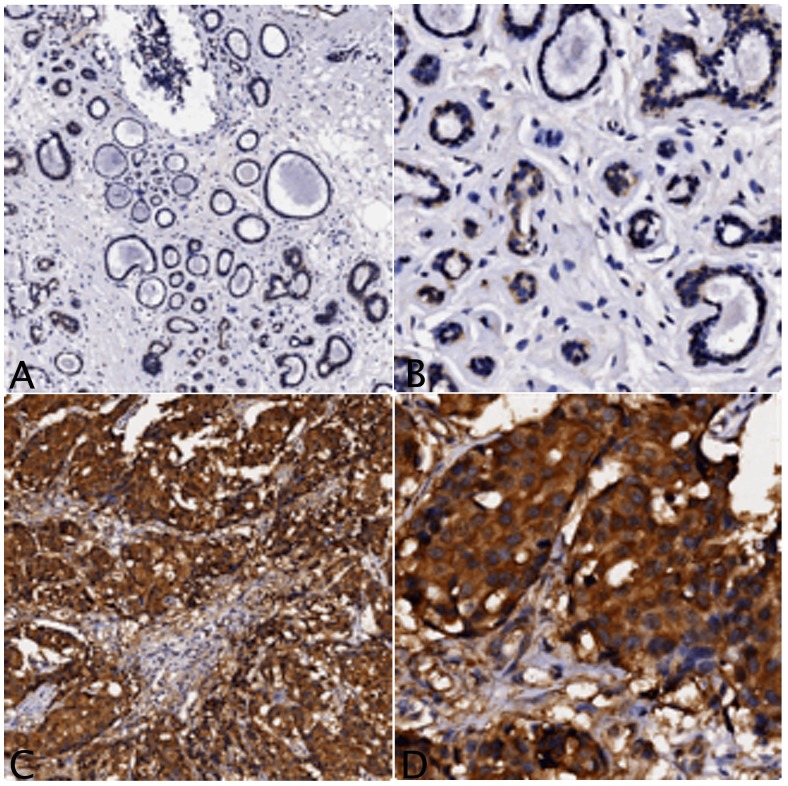
Representative results of XRCC3 protein expression by immunohistochemical analysis.Percentage of positive cells and staining intensity are much lower in adjacent non-cancerous tissue (A.×40; B.×200) than in breast cancer (C.×40; D.×200).